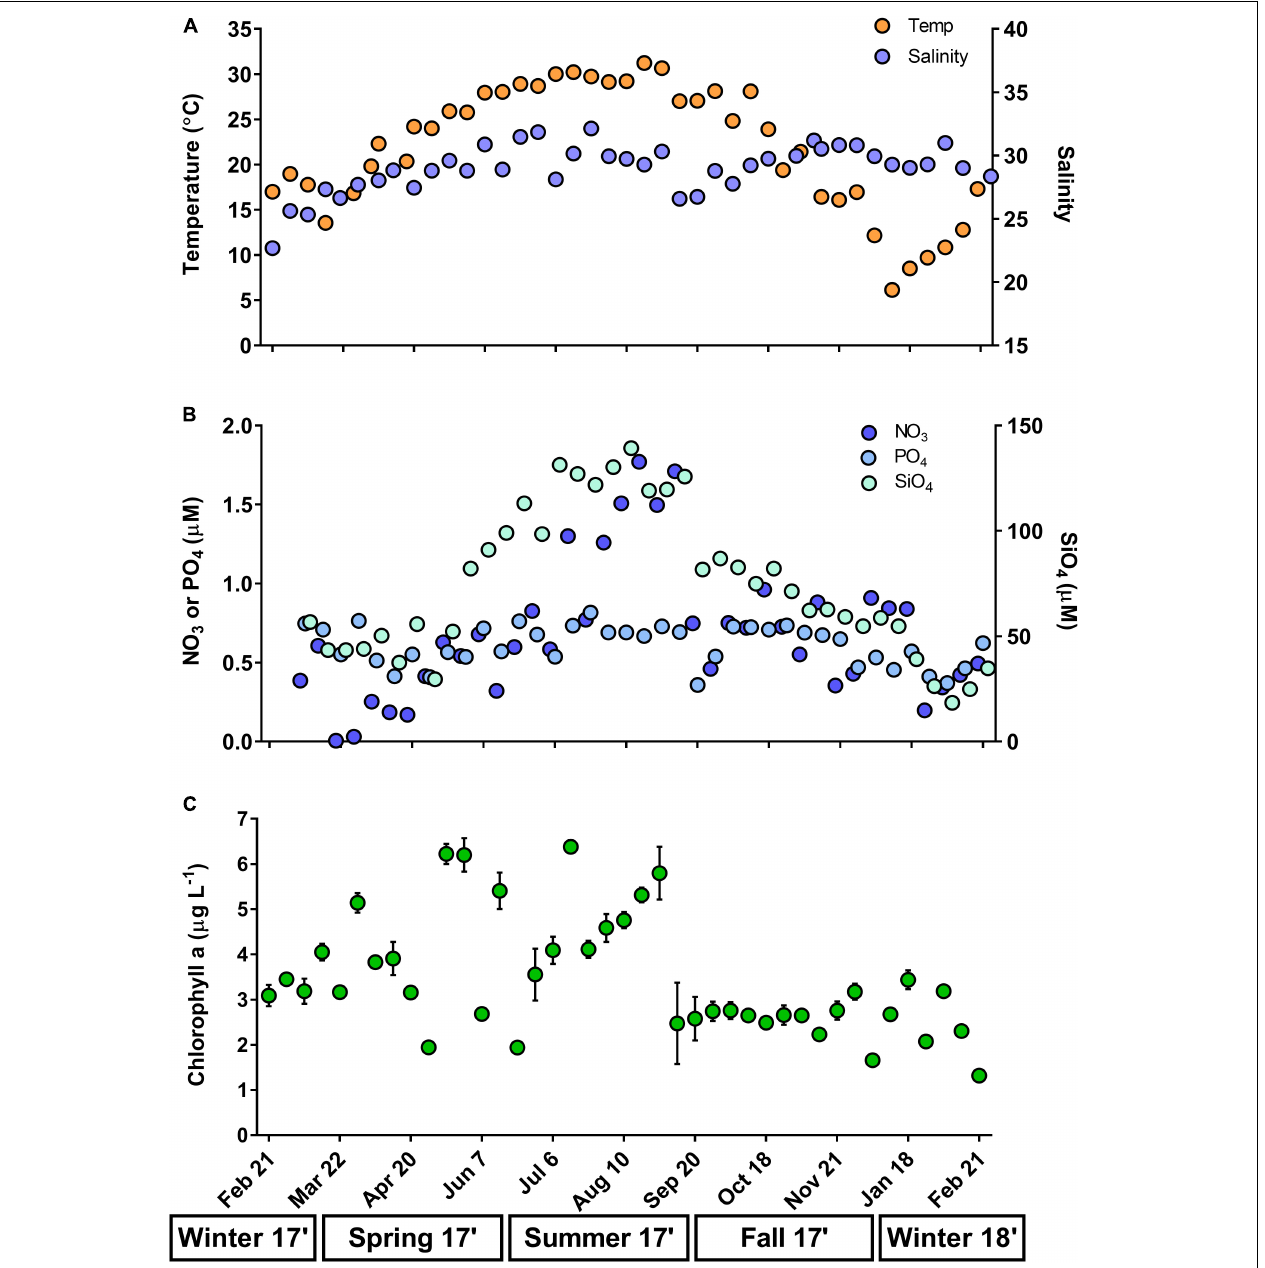
FIGURE 1 | Surface water temperature and salinity (A) , dissolved inorganic nutrients ( µ M; nitrate, NO 3 ; phosphate, PO 4 ; silicate, SiO 4 ; B) , and chlorophyll a ( µ g L − 1 ; C ) at time zero (T0) of each weekly experiment. Error associated with chlorophyll represent ± 1 standard deviation of the triplicate sample mean. Temperature, salinity, and nutrients represent single replicates. Seasons are below x